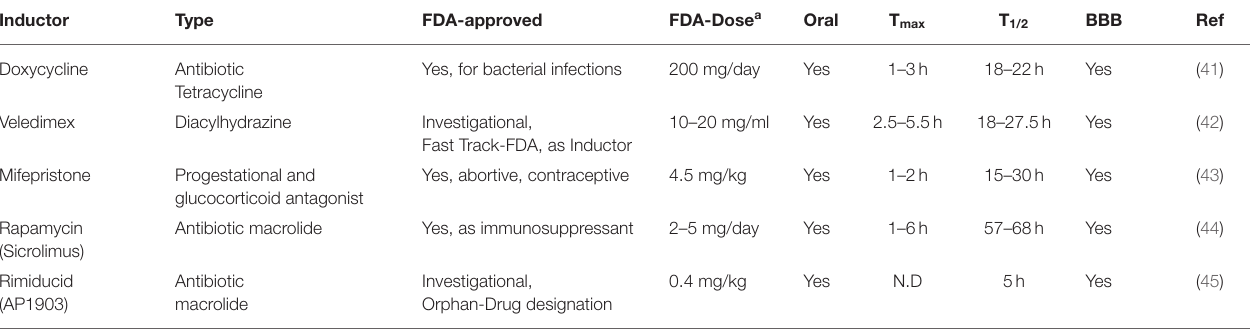
TABLE 2 | Pharmacokinetics of the small molecules used as inductors for inducible immunotherapy.